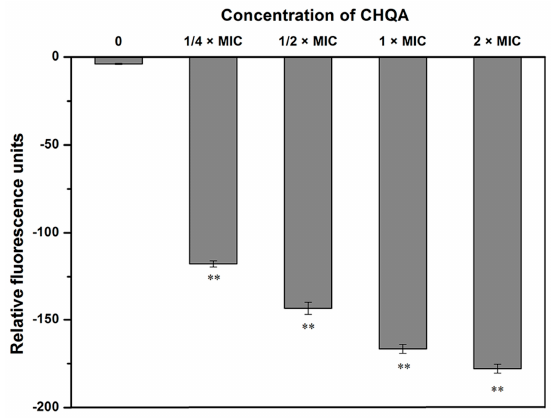
Figure 2. Effect of CHQA on the membrane potential of S. aureus ATCC 6538. Bars represent the standard deviation ( n = 3). ** p < 0.01.